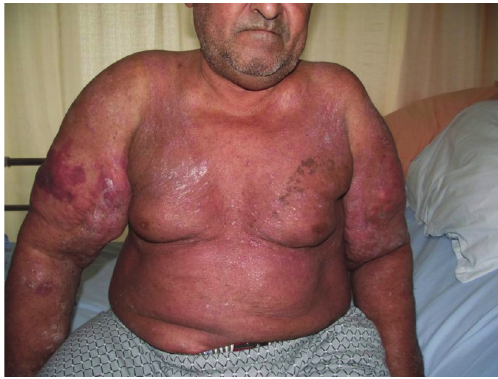
Figure 1: Frontal plane picture showing symmetric lipomatosis lesions at pectoral area and upper